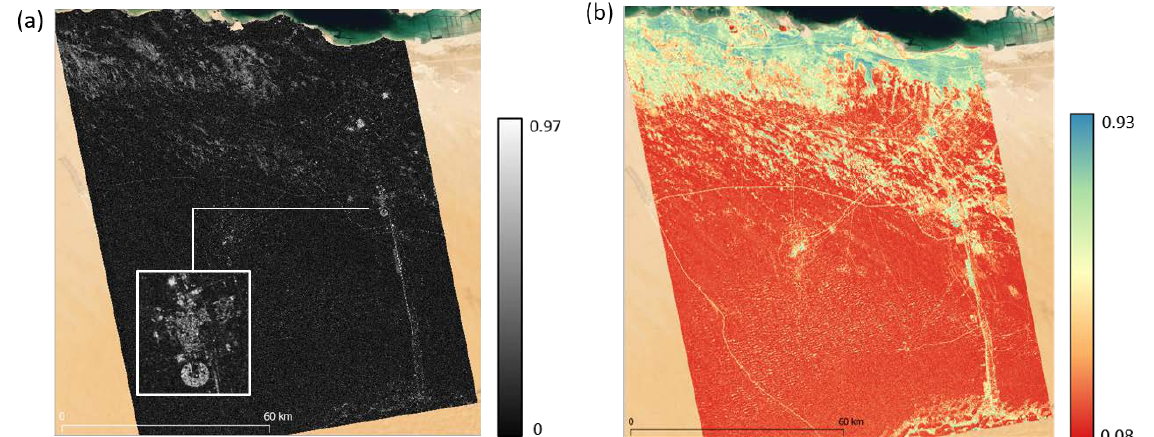
Figure 4. The United Arab Emirates use case: (a) absolute value of the coherence computed between the two images at the longest temporal baseline; the higher the coherence absolute values, the higher the stability of the scene; (b) mean of short-term coherence (MSTC); (© ESRI satellite